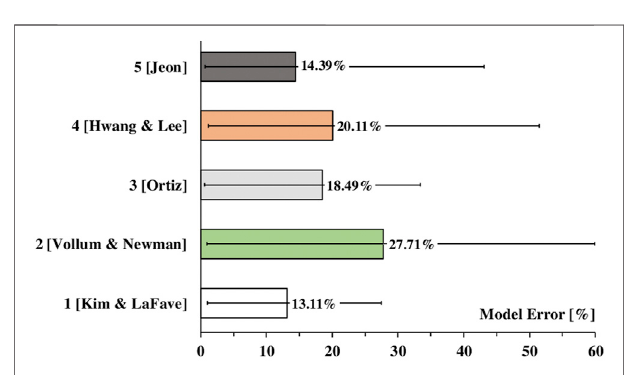
FIGURE4| Modelerrorsintermsof τ max calculatedpereachconsidered literature model by considering all experimental tests.